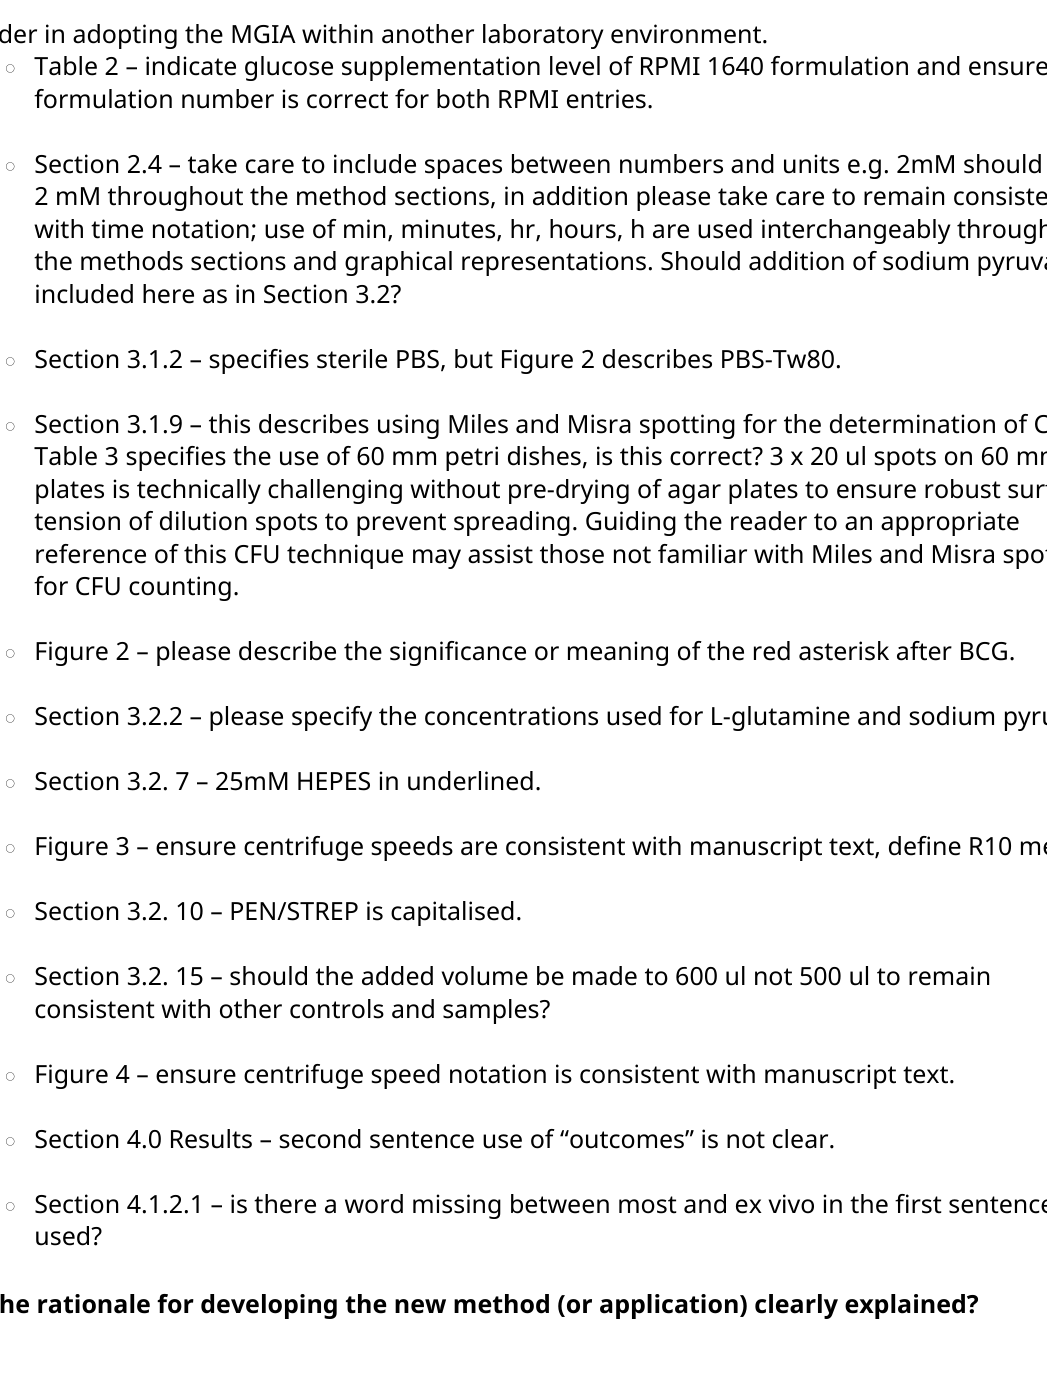
Section 4.0 Results – second sentence use of “outcomes” is not clear.